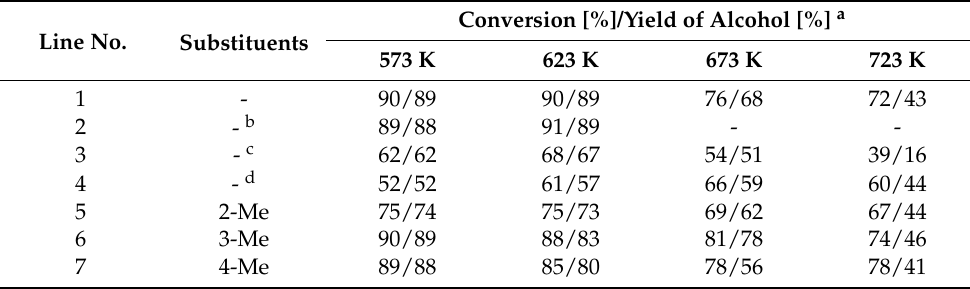
Table 3. Liquid phase transfer hydrogenation of polycyclic derivatives of cyclopentanone with secondary alcohols in the presence of MgO